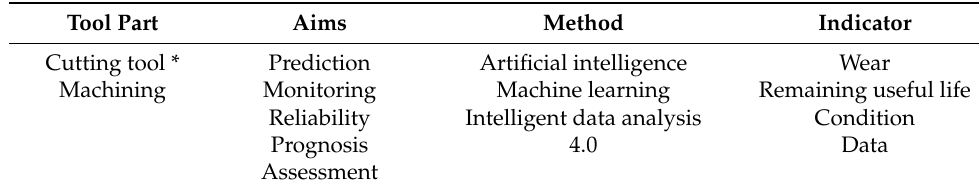
Table 1. List of keywords. Wildcard character (*) includes these different forms of the “tool” word: “tool”, “tools”, and “tooling” Tool Part Aims Method Indicator Cutting tool * Prediction Artificial intelligence Wear Machining Monitoring Machine learning Remaining useful life